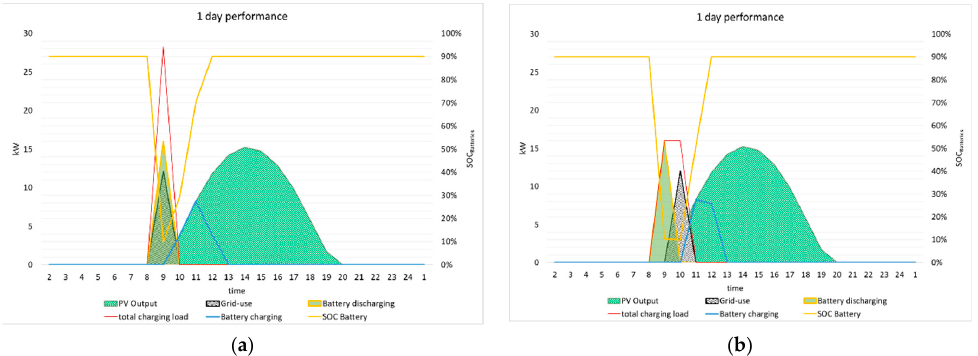
Figure 13. One-day energy performance. ( a ) According to max available power load, ( b ) according to PV performed charging mode.